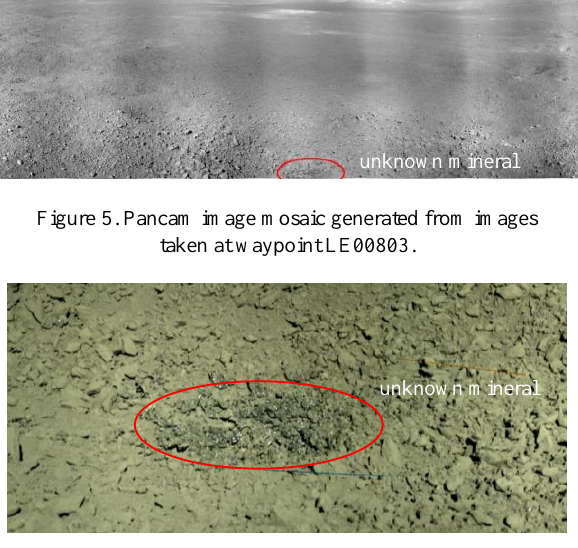
Figure 6. Unknown mineral identified in a color Pancam image